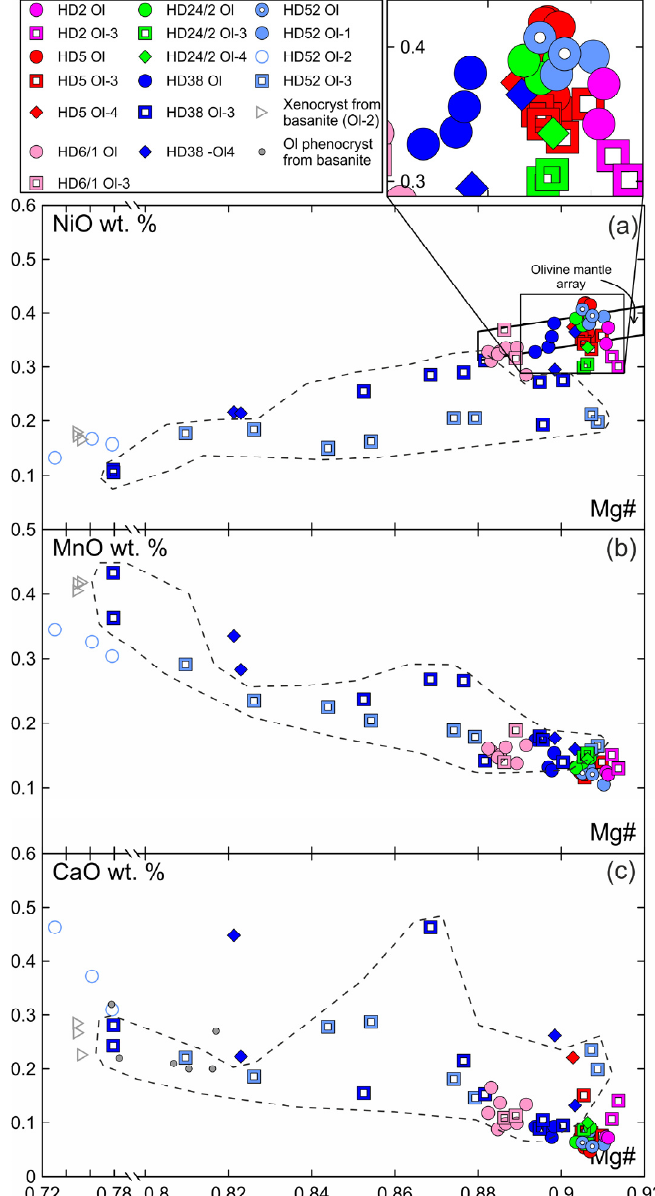
Figure 3. Composition of olivine from Tumusun lherzolite xenoliths. ( a ) NiO-Mg#, ( b ) MnO-Mg#, ( c ) CaO-Mg#. Ol—primary olivine, Ol1—core of olivine with reaction zone at basanite/xenolith contact, Ol2—secondary olivine from reaction zone of Ol1, Ol3—secondary olivine from reaction zone of Opx1, Ol4—secondary olivine from reaction zone of Cpx1. The dashed line show compositions of Ol3 from reaction zone of Opx1 located at basanite/xenolith contact.